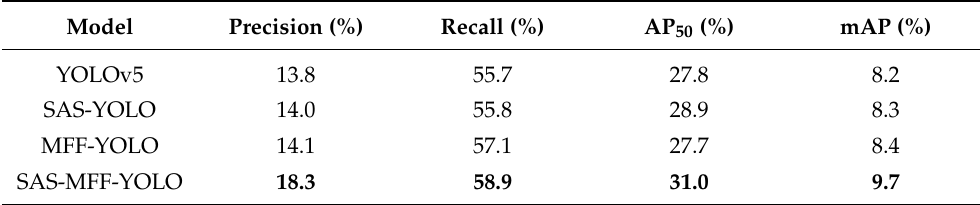
Table 2. The performance of different models on the dataset provided by RSNA. Precision and recall are for pneumonia classification, while AP 50 and mAP are for the task of lesion object detection.